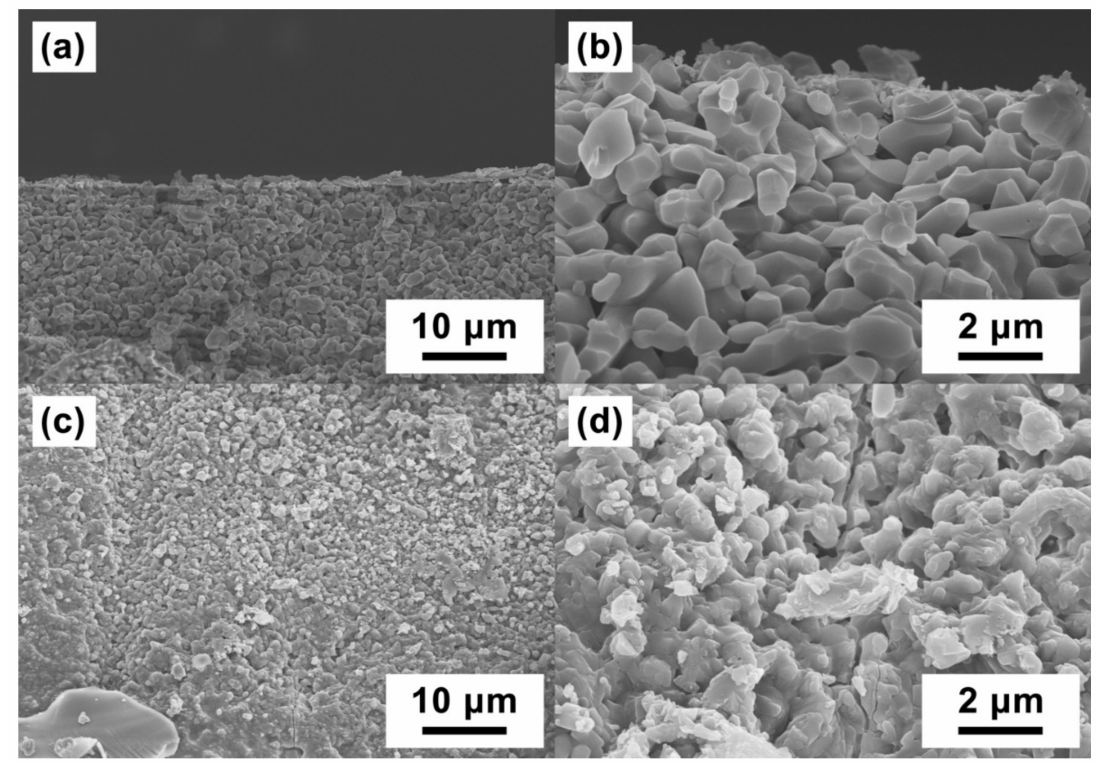
Figure 5. The cross-section view of one laser-fabricated alumina unit from different locations: ( a ) and ( b ): close to the top surface; ( c ) and ( d ): close to the bottom of the sample